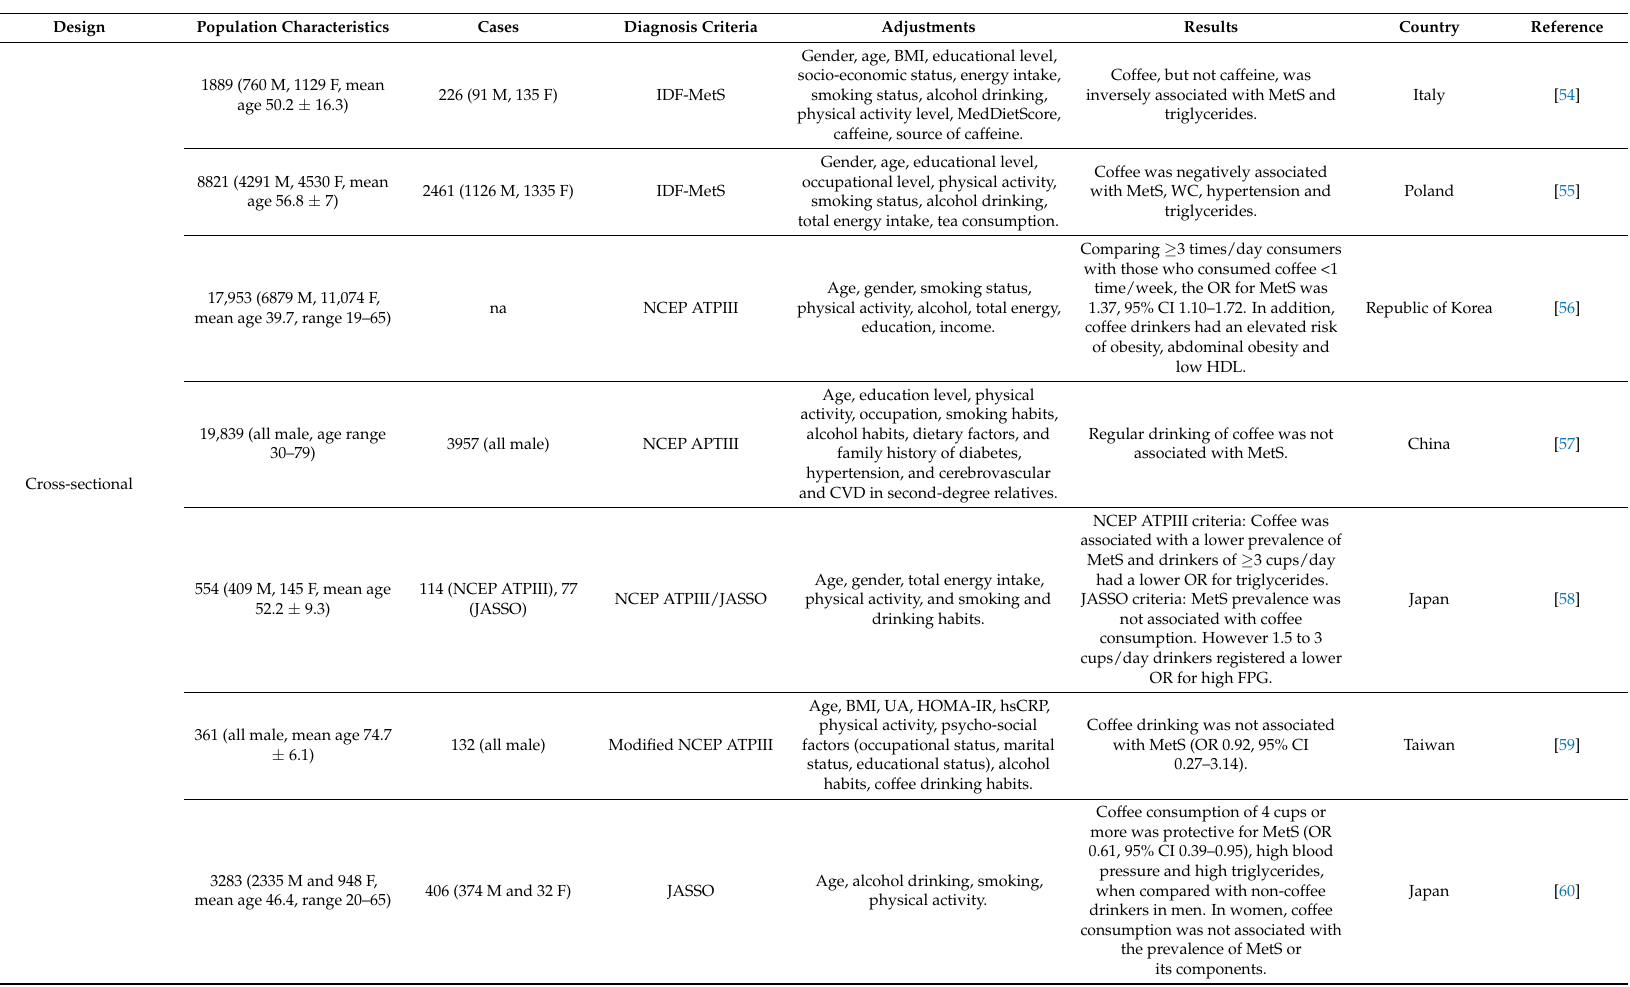
Table 3. Characteristics of studies investigating the relationship between coffee consumption and metabolic syndrome and its components.